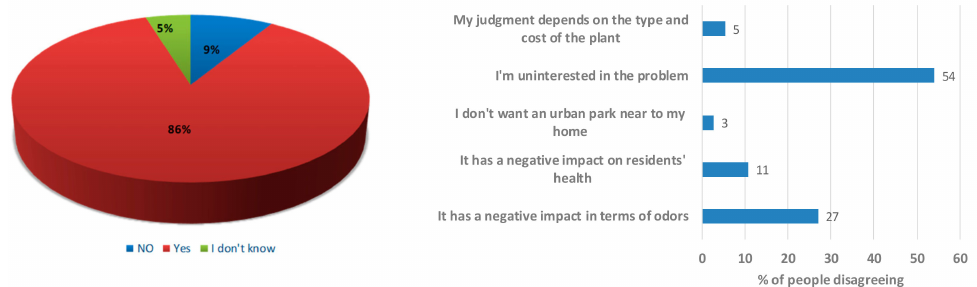
Figure 5. Percentage distribution of answers to the question: “Are you favorable towards the realization of this project?” ( left ) and distribution of the reasons against the project ( right